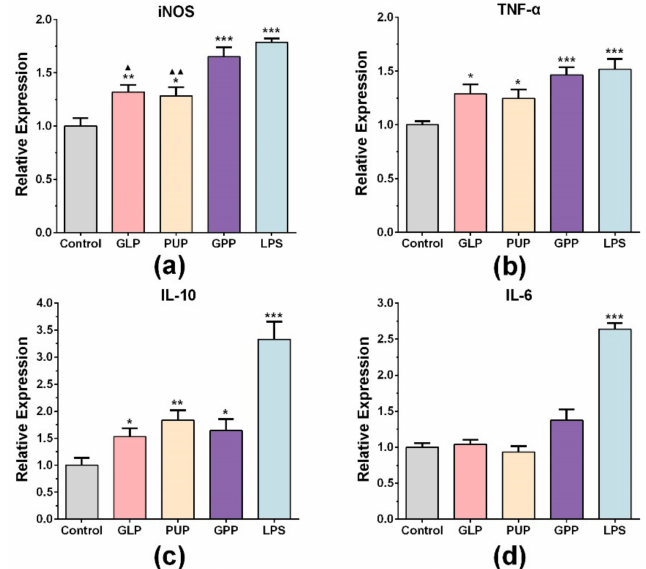
Figure 2. The e ff ect of GLP, PUP and a polysaccharide composition consisting of GLP and PUP in a ratio of 3:1 (GPP) on iNOS, TNF- α , IL-10 and IL-6 mRNA expression, respectively. The mRNA expression level of iNOS ( a ), TNF- α ( b ), IL-10 ( c ) and IL-6 ( d ). Data were expressed as mean ± SEM, * p < 0.05, ** p < 0.01, *** p < 0.001 vs. control group, (cid:78) p < 0.05, (cid:78)(cid:78) p < 0.01 vs. GPP